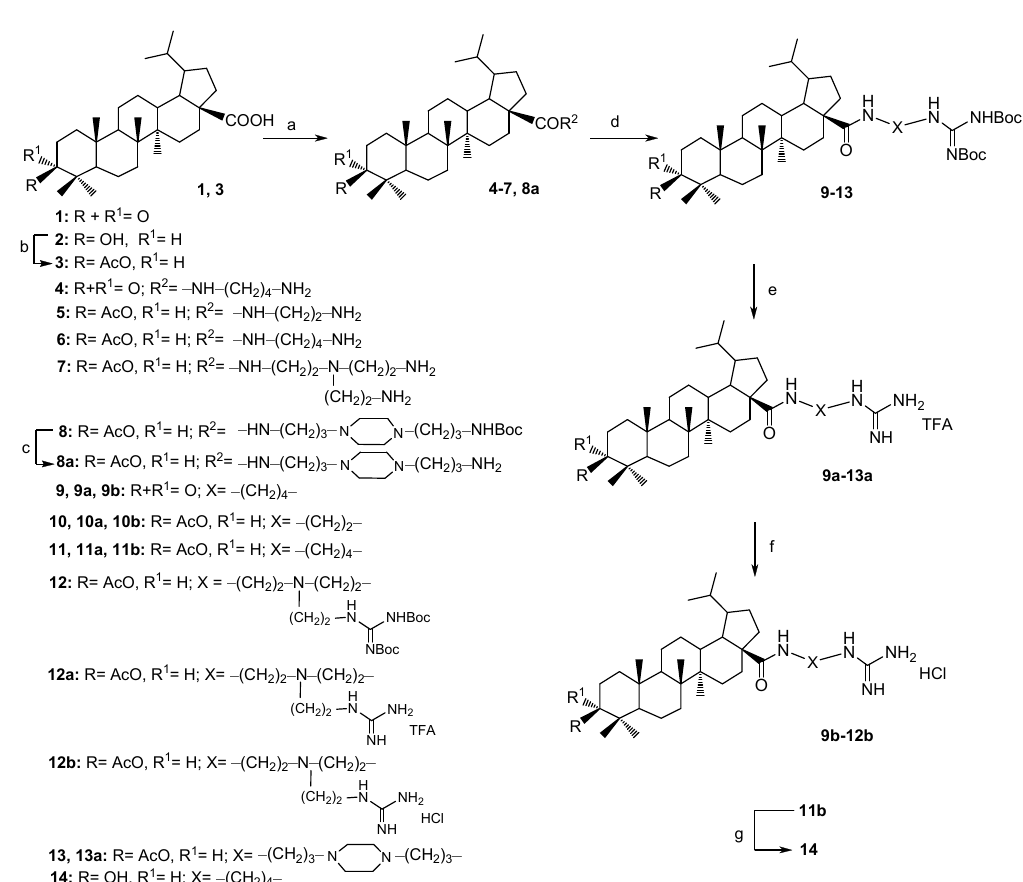
Scheme 1. Synthesis of target compounds 9b – 12b and 14 . Reagents and conditions: ( a ) 1. (COCl) 2 , CH 2 Cl 2